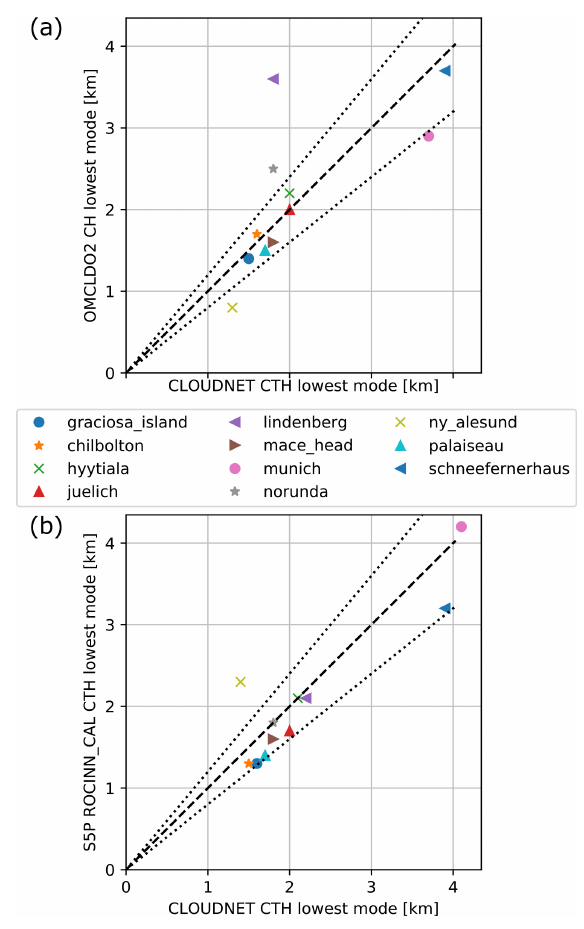
Figure 10. (a) Correlation plot between the lowest CTH modes of OMCLDO2 and Cloudnet. Only sites with more than 70 co-location pairs are considered. Dashed line is the 1:1 line, and dashed lines are the ± 20% deviations from the 1:1 line. (b) The same but be- tween the lowest CTH modes of S5P OCRA/ROCINN_CAL and